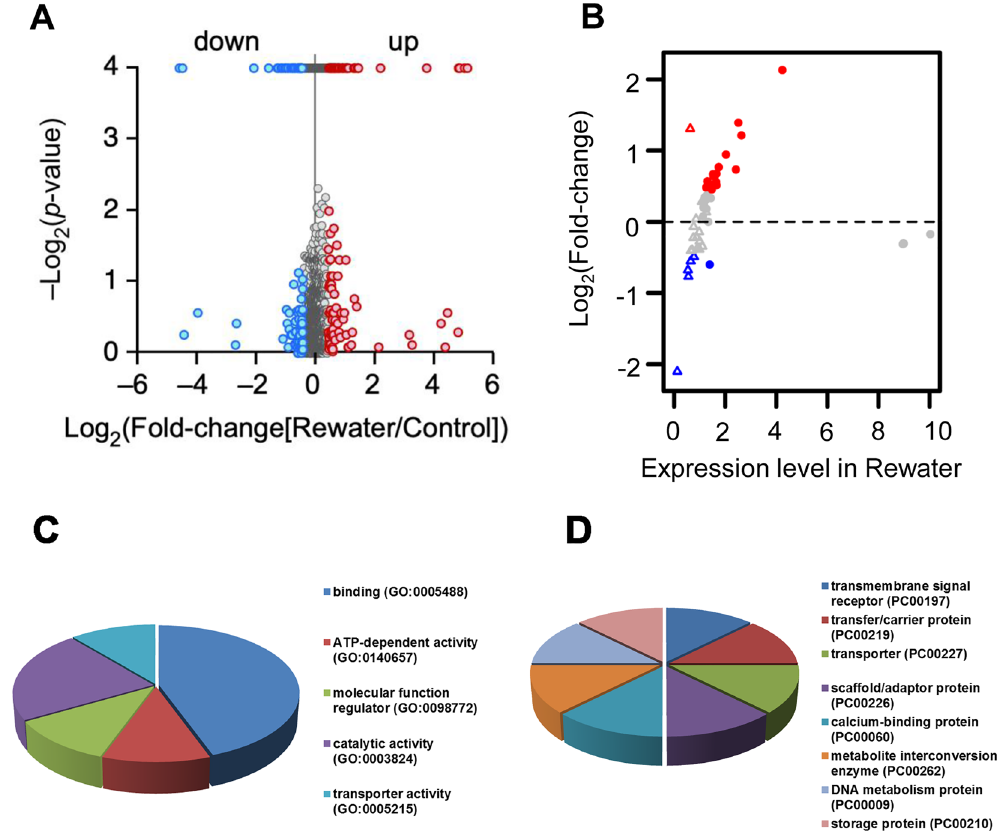
Figure 4. The change in drought-response proteins after rewatering. ( A ) Volcano map showing the DAPs identified following rewater treatment. ( B ) Scatter plots showing the change in abundance of the DAPs from the drought treatments following the rewatering. Red indicates an upregulation following rewatering, while blue represents a downregulation. Circle represents a protein upregulated in the droughted plants, while a triangle represents a downregulated protein. ( C ) GO annotation for the recovery proteins. ( D ) Function analysis for the recovery